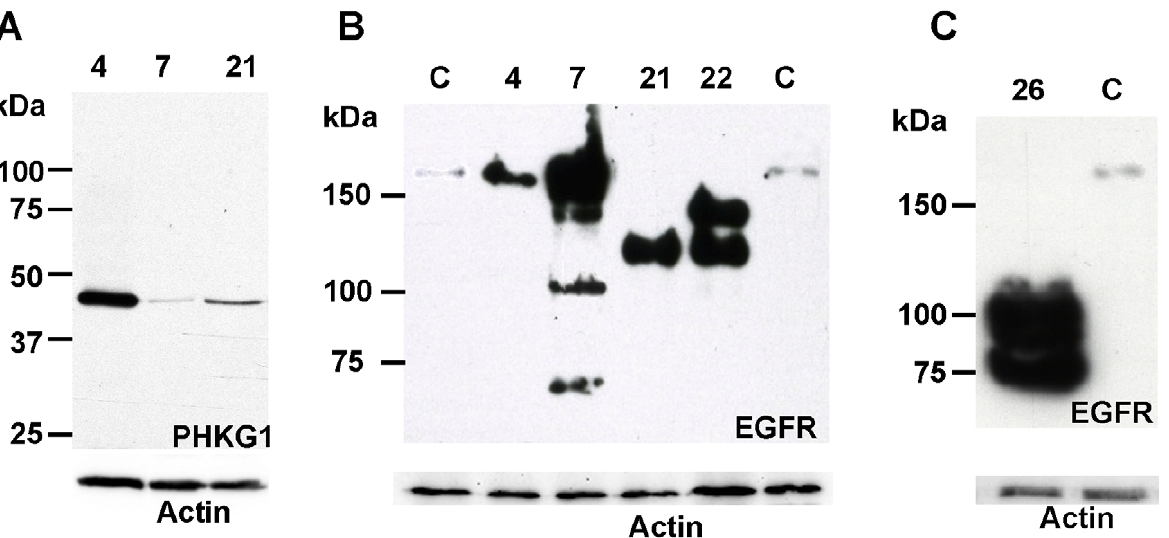
Figure 2. Western blot analysis of proteins encoded by amplified genes. A. Over-expression of PHKG1. The gene was amplified in tumour 4 and not amplified in tumours 7 and 21. B. Over-expression of EGFR. Controls (C): extracts from 2 glioblastomas without EGFR amplification expressing the wild-type form of the protein. Tumours 4 and 7: full-length wild-type EGFR. Tumour 21: EGFRvIII variant. Tumour 22: EGFRvIII variant plus full- length wild-type (the apparent small size of the wild-type form, also present as a minor product in tumour 7, could correspond to a protein with posttranslational modifications). Receptor degradation products are visible in the tumour 7 lane. C. Over-expression of EGFR in tumour 26. The two truncated proteins expressed in this tumour are of the EGFRvI variant form. Actin: loading control.